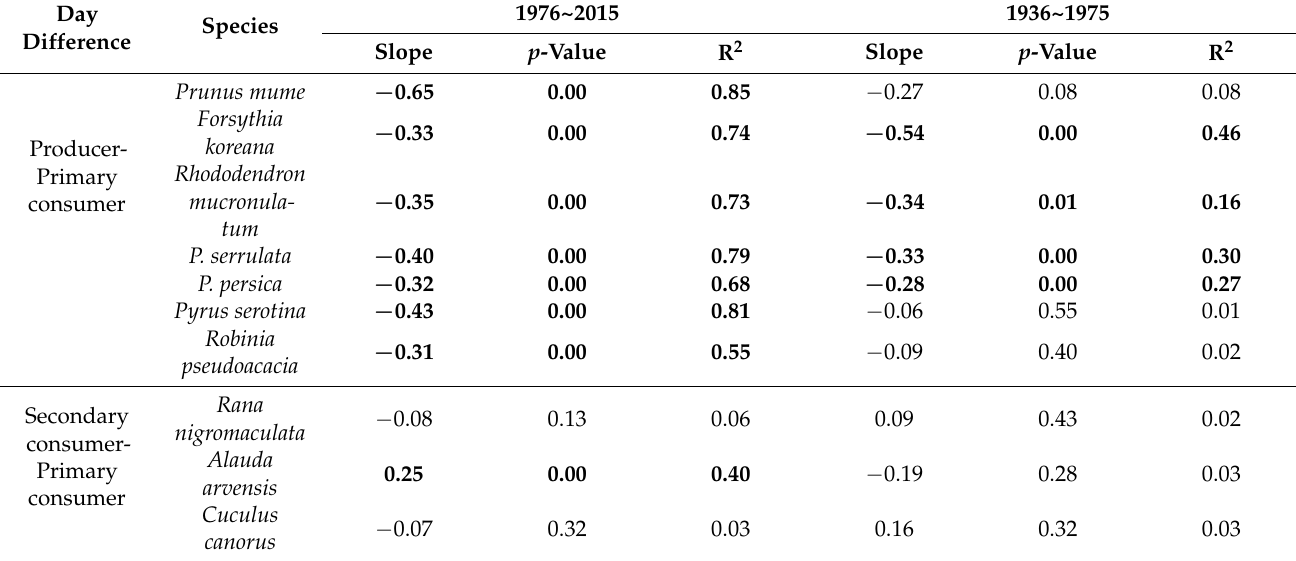
Figure 4. Variation in the day difference of phenological events between interacting species. The average day differences is calculated by subtracting the phenological date of the primary consumer, the butterfly, from the average phenological date of each species. Producers include 7 plant species to be studied, and consumers include 3 animal species of secondary consumer. Table 4. The regression of day difference between interacting species by each sites during 1976~2015, 1936~1975. The bold numbers indicates the number of statistically significant values ( p <